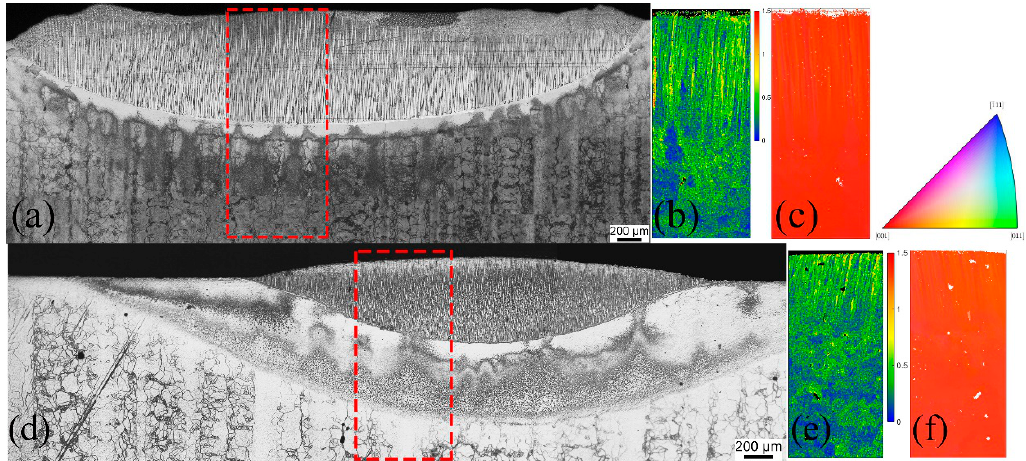
Figure 1. Optical micrographs of the transverse section with the ( a ) laser re-melted sample and ( d ) the plasma arc re-melted sample, which clearly show the fusion zone, heat-affected zone, and base metal. Corresponding images ( b ) and ( e ) are the kernel average misorientation (KAM) maps, and ( c ) and ( f ) are the inverse pole figure (IPF) maps, respectively. The red-dotted box in the optical images shows the electron backscatter diffraction (EBSD) observation region.